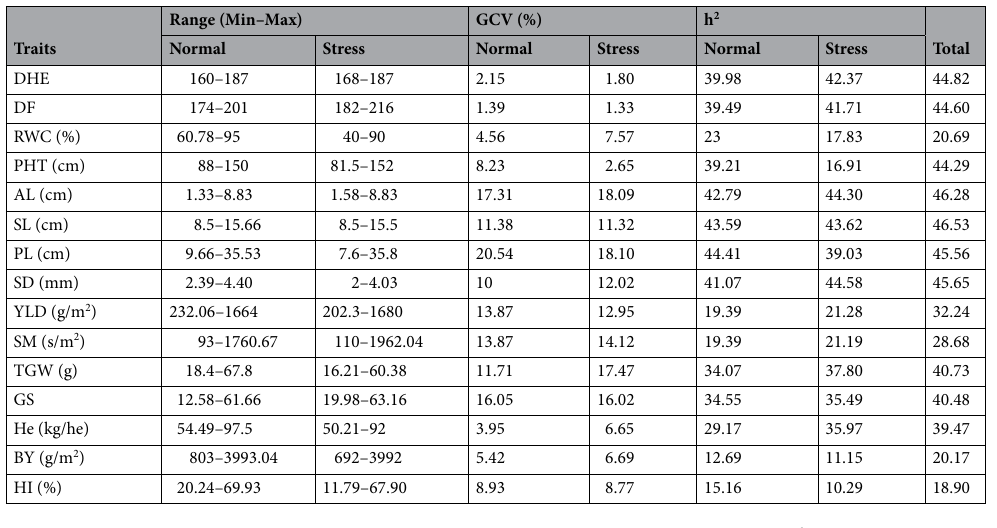
Table 2. Range, genotypic coefficient of variation (GCV) and broad sense heritability (h 2 ) of wheat traits evaluated under normal and water-stressed conditions during 2 years. DHE, days to heading; DF, days to flowering; RWC (%), relative water content; PHT (cm), plant height; AL (cm), awn length; SL (cm), spike length; PL (cm), peduncle length; SD, stem diameter (mm); YLD, (g/m 2 ) grain yield; SM, spike per m 2 ; TGW (g), thousand-grain weight; GS, grains per spike; He, hectoliter (kg/he); BY (g/m 2 ), biological yield; HI (%), harvest